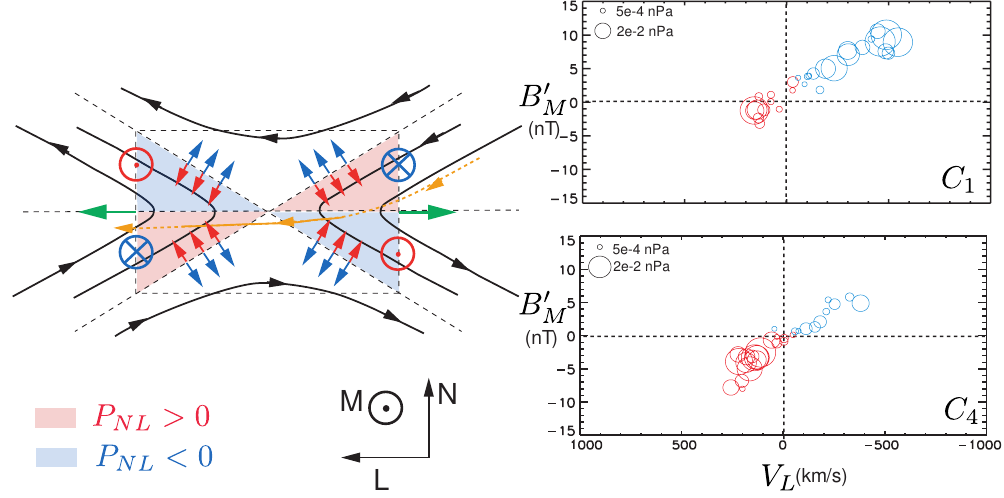
Fig. 5. Left: sketch of the reconnection plane. Black lines represent the in-plane magnetic field lines, red and blue circles represent the sign and amplitude of the quadrupolar out-of-plane Hall magnetic field component, green arrows represent the proton outflow, red arrows represent the hall electric force, balanced by the blue arrows representing the pressure gradient force. This force balance, in the x-direction, − ∂ z P i ∼ − enE x lead to the prediction of the sign of P NL , colored in each quadrant of the decoupling region (dashed black square). The possible spacecraft trajectory is represented as the yellow curve. The solid part of this curve is the location where the data presented in the right panel is thought to be. Right: scatter plot for C 1 (top) and C 4 (bottom) of the sign and amplitude of P NL coded as colored and variable radius circles in the ( B ′ M , V L ) . Blue and red circles means negative and positive values, respectively, as in the sketch on the left.